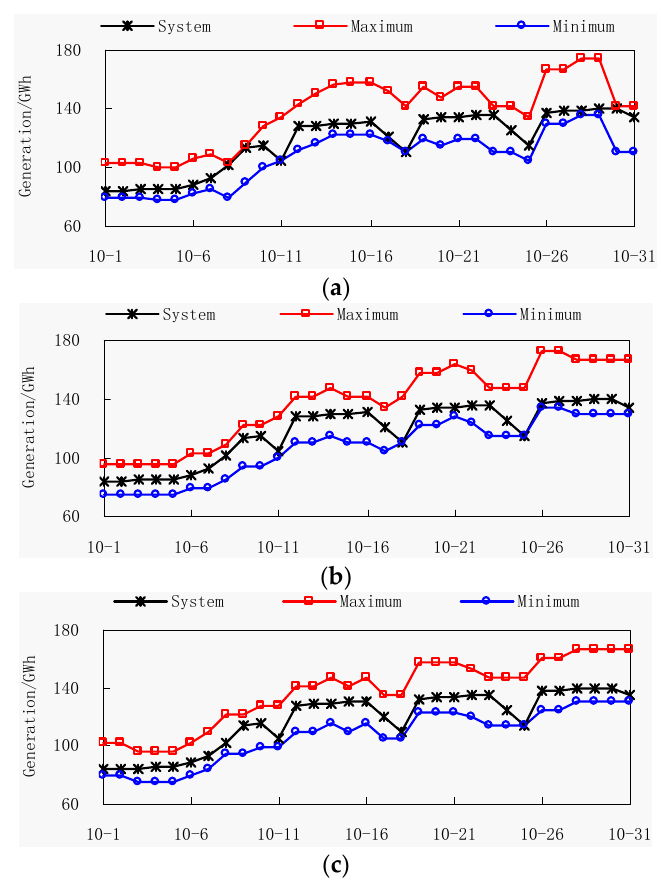
Figure 7. Energy balance maps by three methods: ( a ) POA; ( b ) first adjustment; ( c ) IPOA.